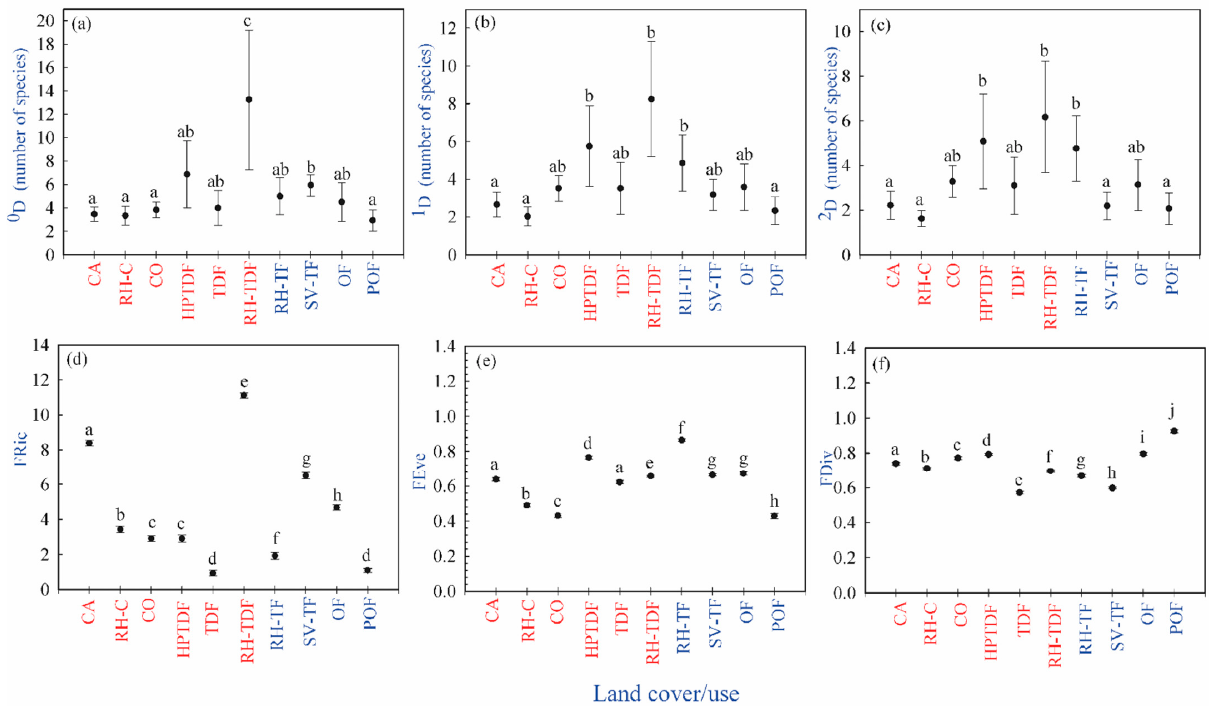
Figure 2. Taxonomic and functional diversity for the amphibian’s assemblage per site in a hetero- geneous landscape in west-central Mexico. ( a – c ) Non-asymptotic coverage-based rarefaction and extrapolation values of taxonomic diversity ( 0 D, 1 D and 2 D), maximum standardized coverage Cmax = 93%. ( d – f ), and functional diversity metrics (functional richness [FRic] ( d ), functional evenness [FEve] ( e ), functional divergence [FDiv] ( f )). Codes: sugar cane field (CA), riparian habitat surrounded by crops (RH-C), cornfield (CO), highly perturbated tropical dry forest (HPTDF), tropical dry forest (TDF), riparian habitat surrounded by tropical dry forest (RH-TDF), riparian habitat sur- rounded temperate forest (RH-TF), secondary vegetation surrounded by temperate forest (SV-TF), oak forest (OF) and pine-oak forest (POF). Tropical habitats are represented in red and temperate habitats are shown in blue. Different lowercase letters indicate significant differences ( p ≤ 0.05) among cover/use